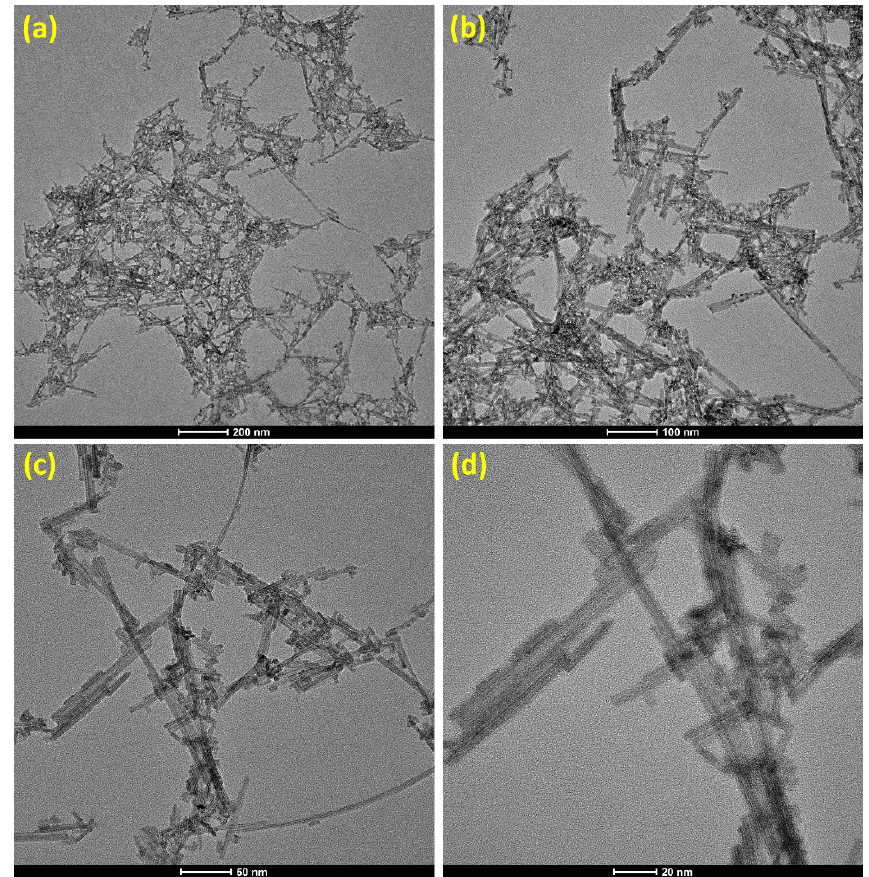
Figure 2. ( a – d ) TEM images of the WS 2 nanorods at the different scales.